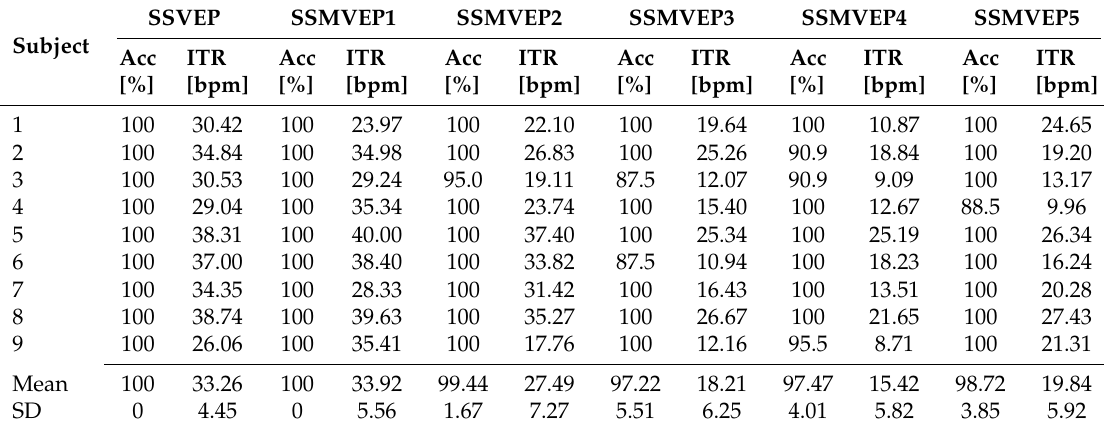
Table 2. Results of the online SSMVEP experiment (spelling of the word “INVITE” in 18 trials); presented below are the average values of the accuracy (Acc) and the information transfer rate (ITR) of each individual subject, for all tested SSMVEP stimulation